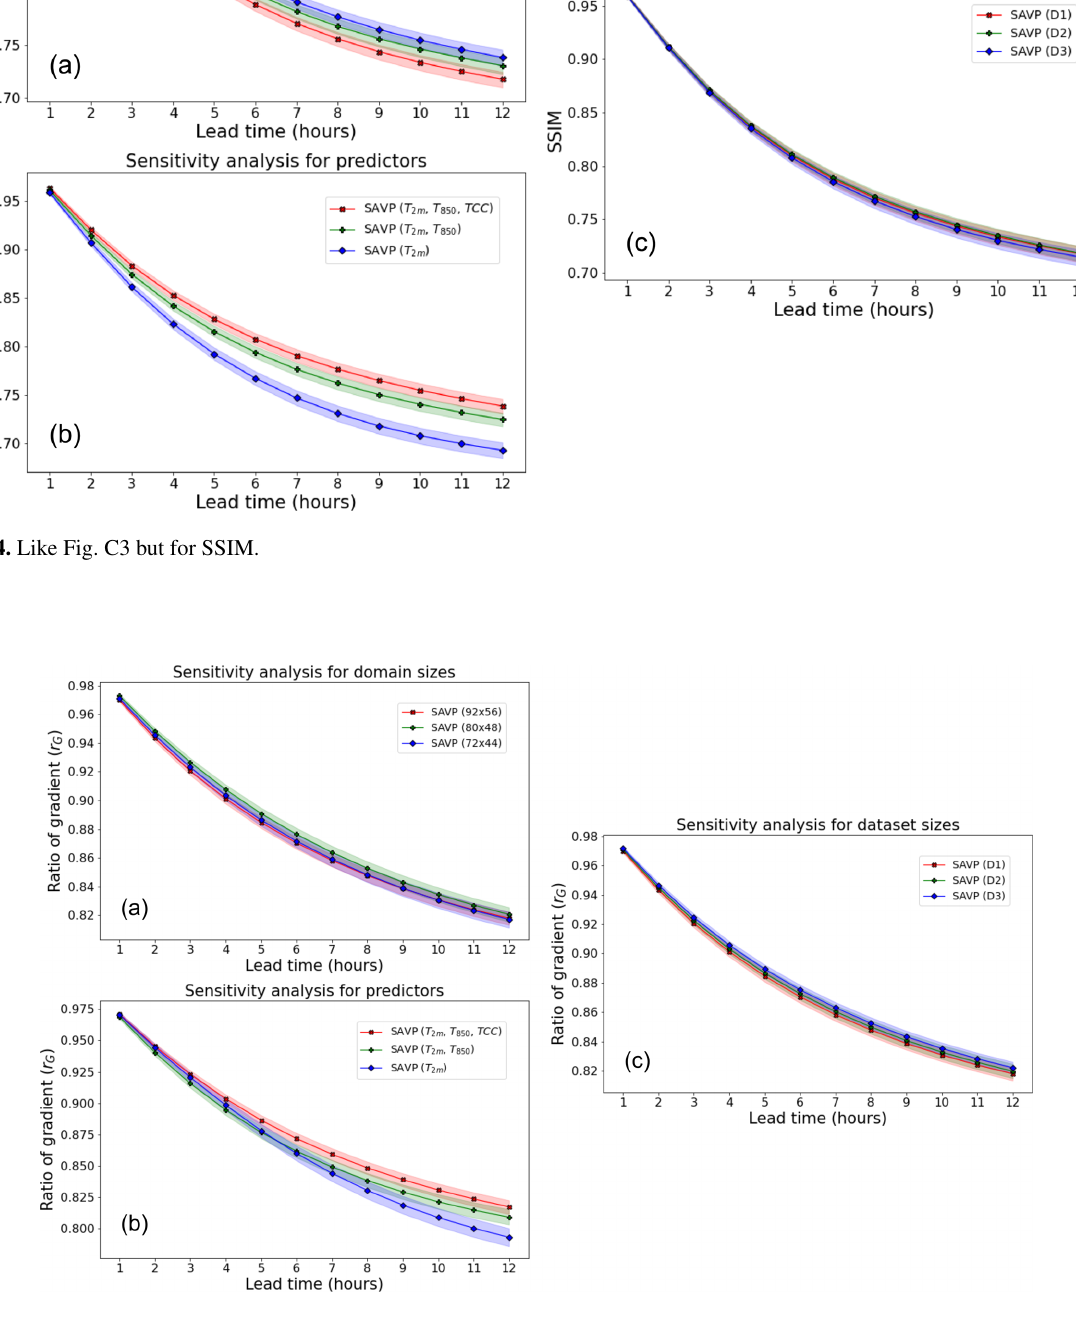
Figure C5. Like Fig. C3 but for the gradient ratio r G .